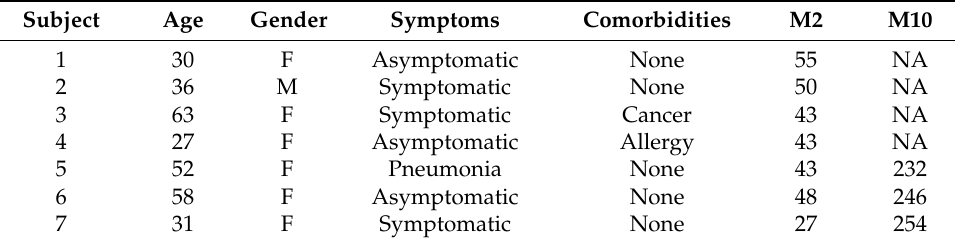
Table 2. Clinical and laboratory characteristics of the seronegative individuals at